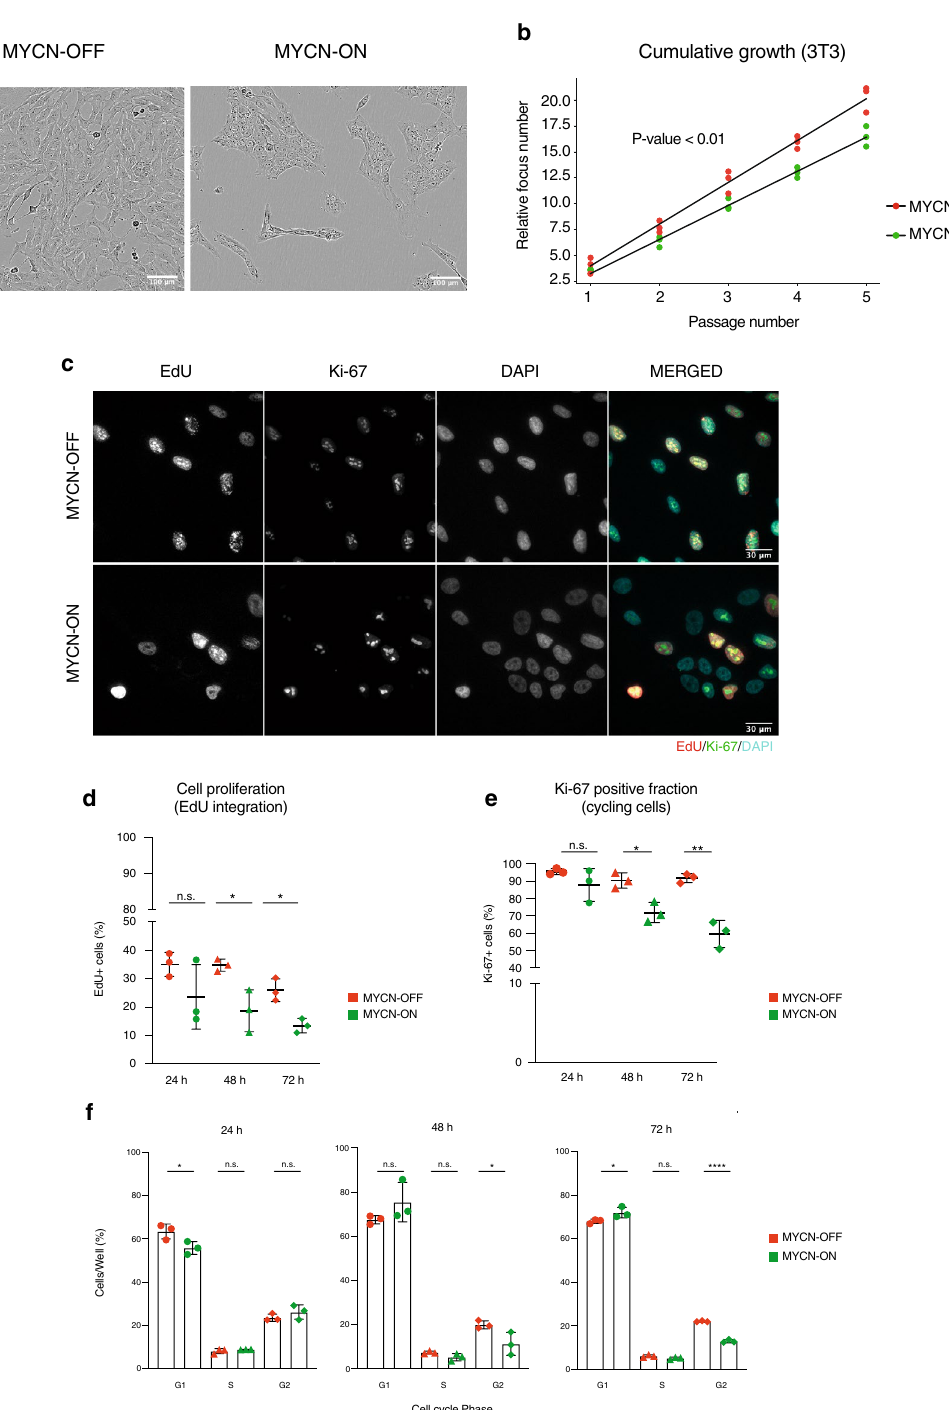
Figure 2. MYCN-ON cells undergo a slow-down in proliferation evidenced by reduced EdU incoporation and Ki-67 staining. ( a ) Phase contrast image of the corresponding cell line in both conditions 72 h p.i. ( b ) focus forming (NIH3T3) assay measuring the oncogenic potential of MYCN by calculating the cumulative increase in cell number. ( c ) Representative images of MYCN ON and OFF cells at 72 h p.i., after immunofluorescence staining for EdU (red), Ki-67 (green) and counterstaining with DAPI (cyan). Images were visualised and annotated in Fiji (v.2.0.0-rc-69/1.52p; http:// imagej. net/). ( d ) EdU incorporation immunofluorescence, expressed by the number of EdU positive nuclei relative to the total number of cells, in MYCN-ON and MYCN-OFF cells over time and ( e ) quantification of Ki-67, expressed by the number of Ki-67 positive nuclei relative to the total number of cells in MYCN-ON and MYCN-OFF cells over time. Error bars represent SD of the three biological replicates. ( f ) DAPI-based cell cycle staging upon MYCN activation. Statistical differences examined by unpaired Student’s t-test. Error bars represent SD of the three biological replicates. (n.s. = not significant, *p-value < 0.05; **p-value < 0, 01; ***p-value < 0.001). Scale bar = 400